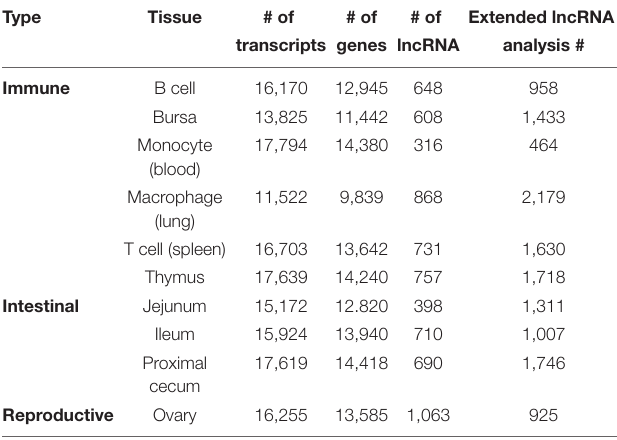
TABLE 1 | The number of transcripts, genes, and lncRNA by